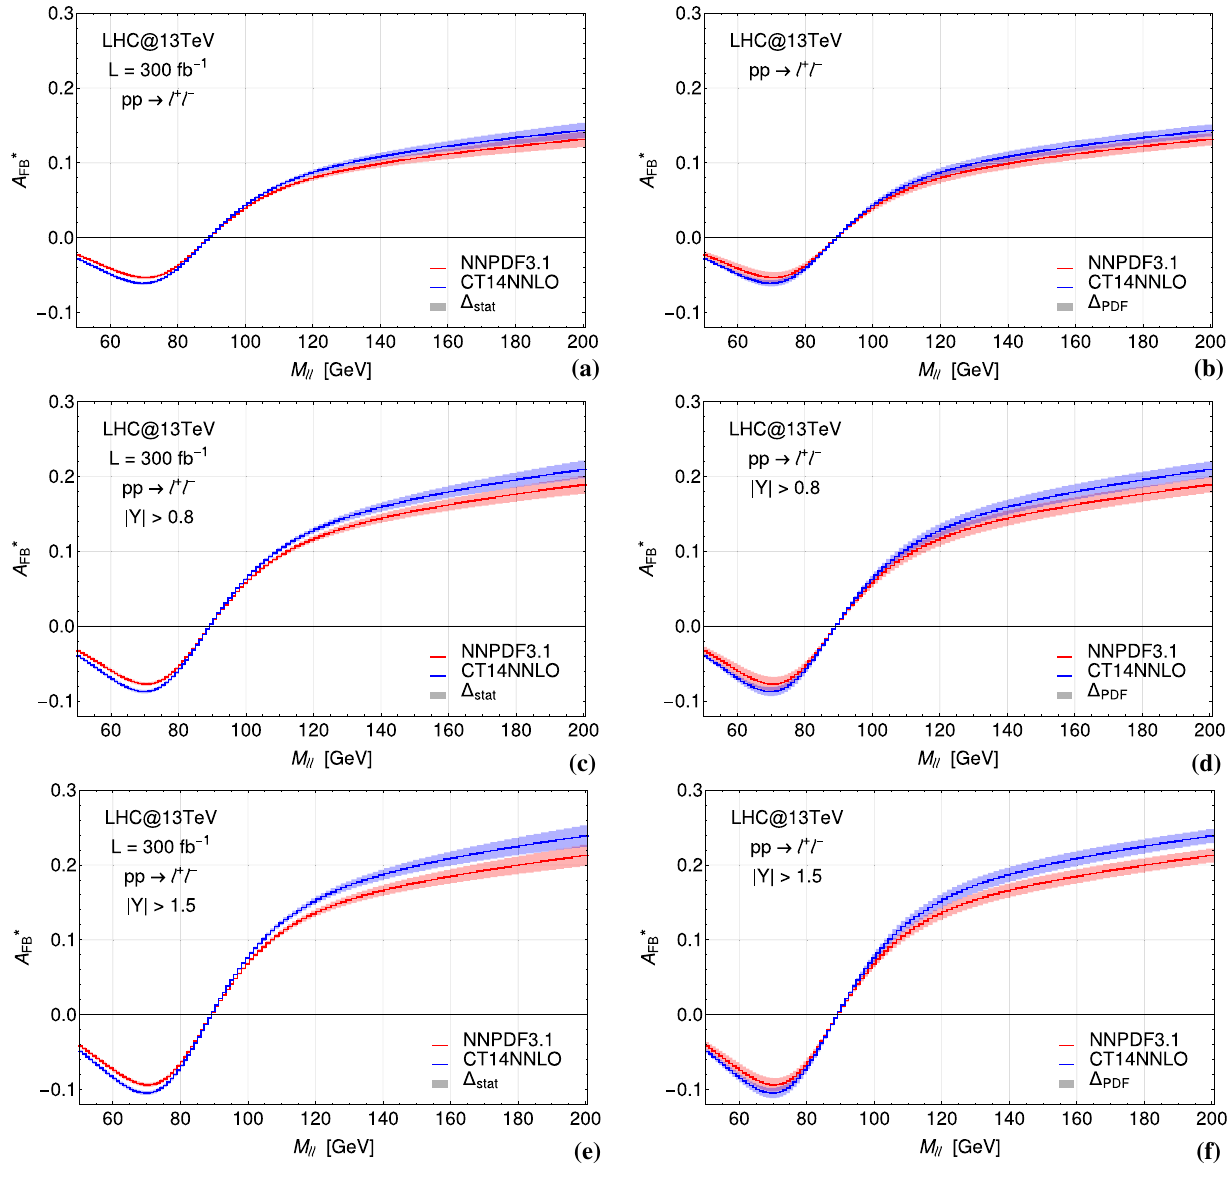
Fig. 1 A ∗ with its statistical (left column) and PDF (right column) error bands obtained with the CT14, and NNPDF3.1 PDF sets with a rapidity FB cut of | y | > 0 (first row), | y | > 0 . 8 (second row) and | y | > 1 . 5 (third